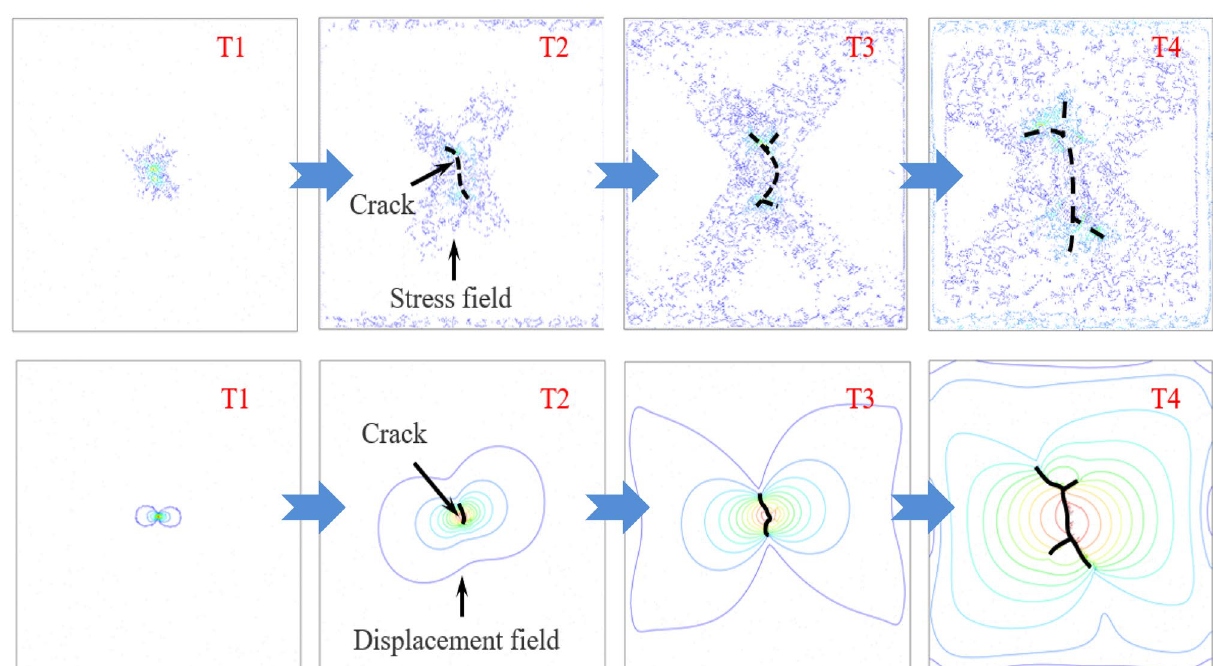
Figure 12. Stress field and displacement field of elastic–plastic soils at different times during fracture